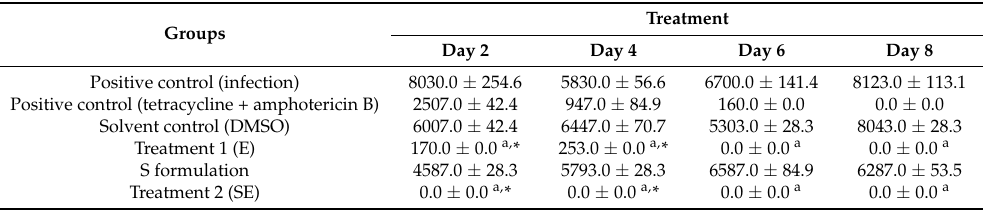
Table 5. Fungal loads (CFUs) obtained from the culture of vaginal fluid collected during the treatment period for therapeutic treatment against C. albicans ATCC 10231.